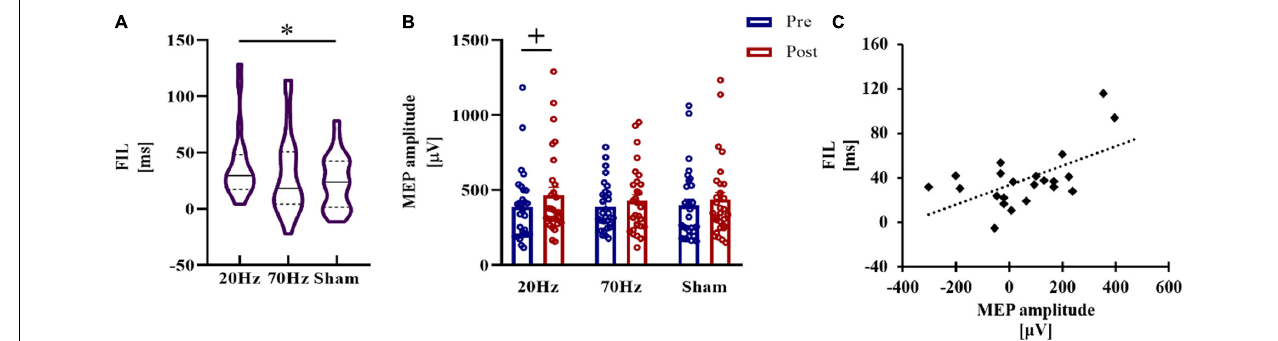
FIGURE 4 | Results of the SRTT experiment. (A) Implicit motor learning during FIL in SRTT. A significant RT reduction was only obtained in the 20 Hz condition. (B) Marginally significant increases in MEP amplitude after TI stimulation at 20 Hz. (C) RT reduction of FIL and the MEP increase in the 20 Hz condition was significantly positively correlated in the 20 Hz condition. Error bars represent SEM; + marginally significant at 0.05 < p corrected < 0.1, ∗ significant at p corrected < 0.05.